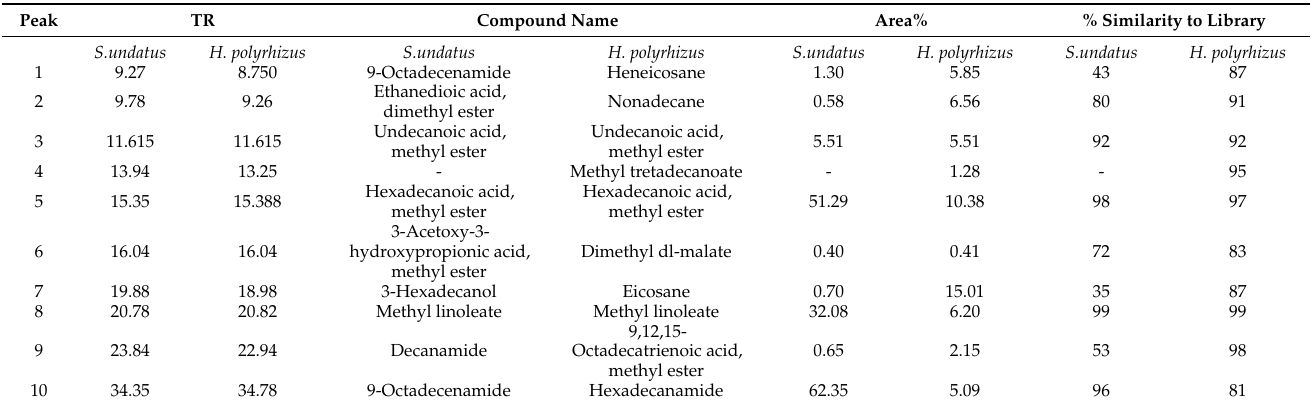
Table 2. Retention times and areas measured by the team, FAMEs in two varieties of pitahaya Selenicerus undatus and Hylocereus polyrhizus . T R (retention time). In the spaces where a hyphen was placed is an unidentified